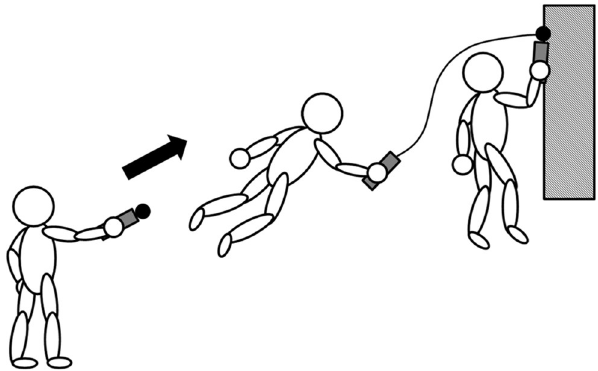
Figure 1. Concept of the TSMD.